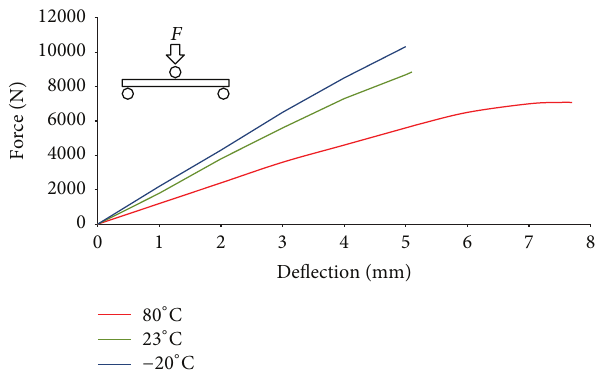
Figure 4: Plot of the average load-deflection relationships for Corian (PMMA/ATH) panels subjected to concentrated-load bend- ing at various ambient temperatures.